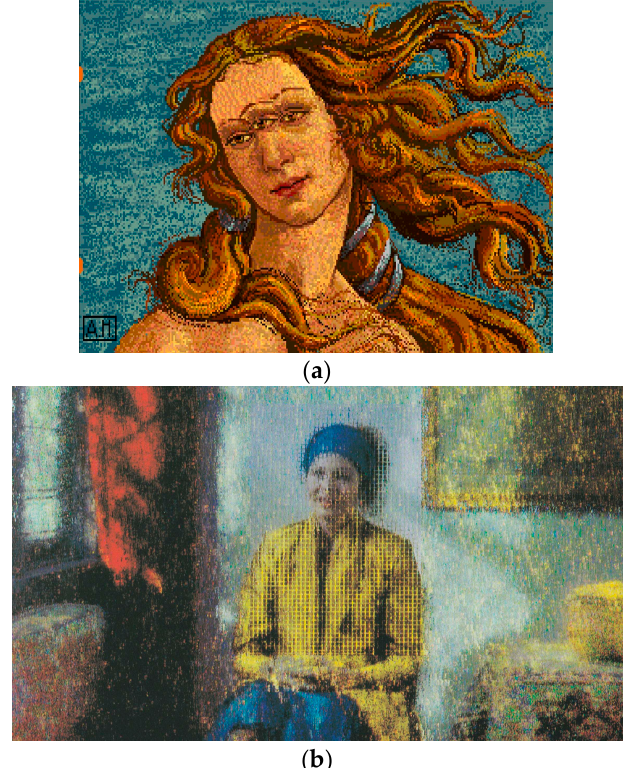
Figure 8. The use of the digital images by Andy Warhol and Wim Wenders: ( a ) A. Warhol, Venus ; ( b ) W. Wenders, Woman by the window #2